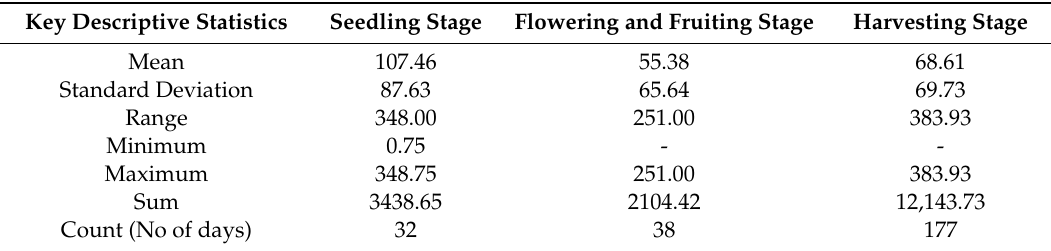
Table 2. Descriptive measures of total daily power consumption (Cooling and Heating both in kWh) during three stages of the capsicum crop cycle.